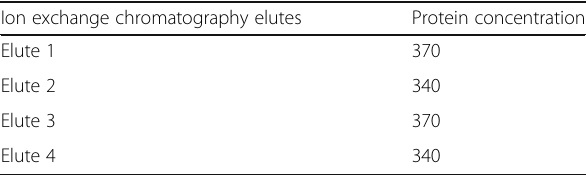
Table 1 Comparison of protein concentration ( μ g/mL) in Cucumis sativus seeds extract by different buffers after dialysis S.no